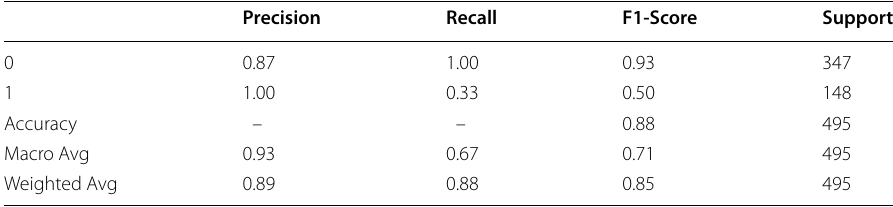
Table 9 Experiment 2 with ASTD dataset